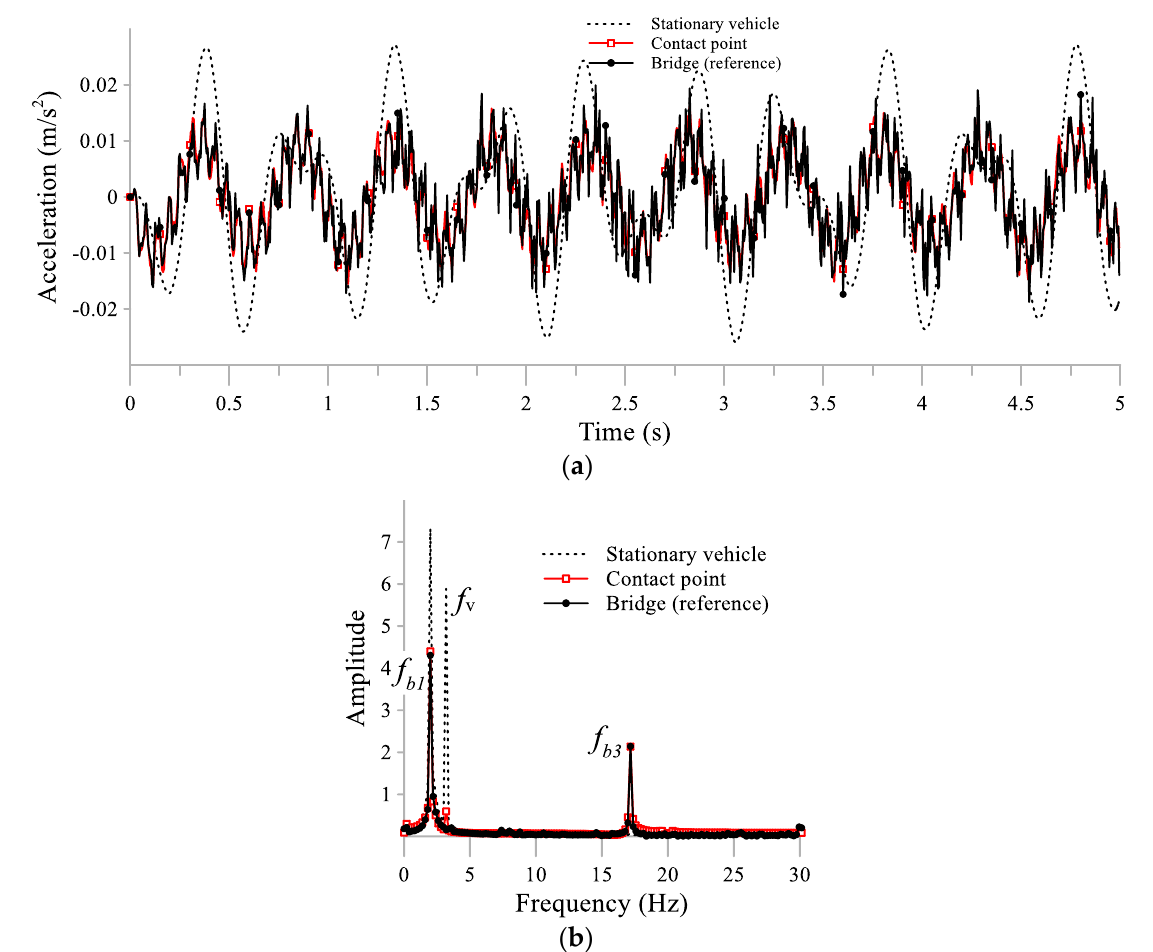
Figure 19. Dynamic responses due to a moving vehicle at a speed of 5 m/s ( a ) for the acceleration response of the 3.18-Hz